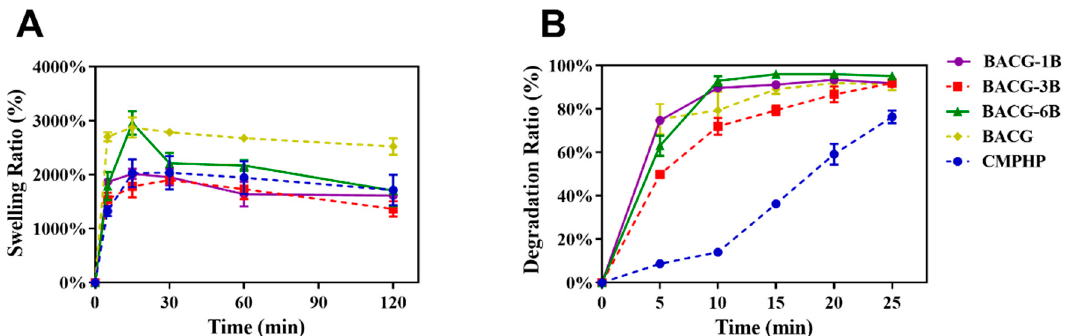
Figure 3. The swelling and degradation behaviors of BACG, BACG-1B, BACG-3B, BACG-6B, and CMPHP. ( A ) The swelling behaviors in phosphate-buffered saline (PBS); ( B ) the degradation behaviors in lysozyme solution. The data correspond to the mean ± SD ( n = 3).